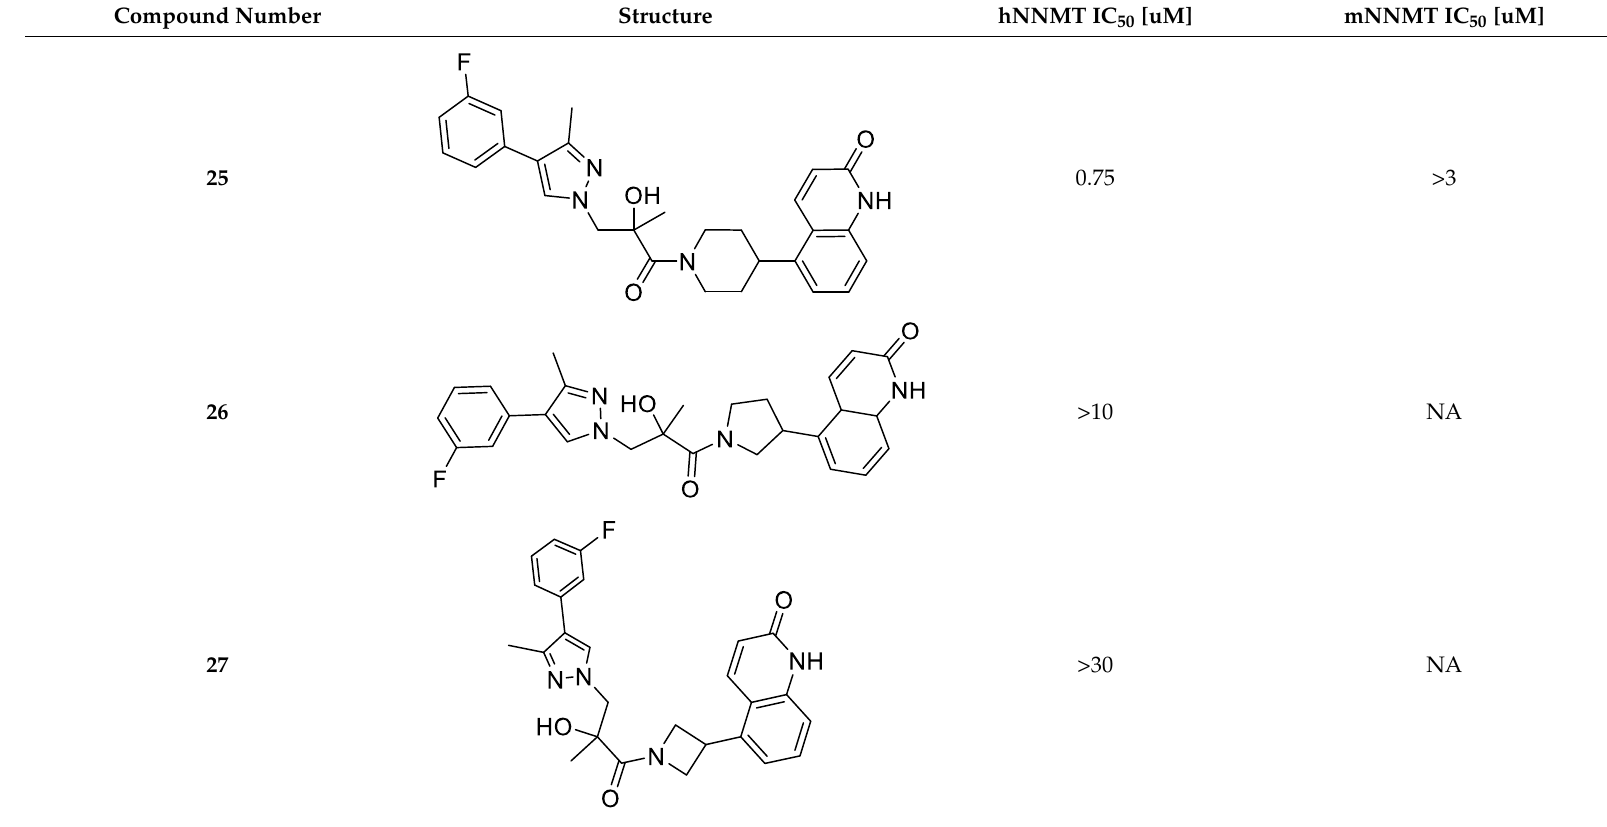
Table 3. Overview of NNMT inhibitors ( 25 )–( 32 ) and human/rat/mouse liver microsome (HLM/RLM/MLM) data. Compound Number